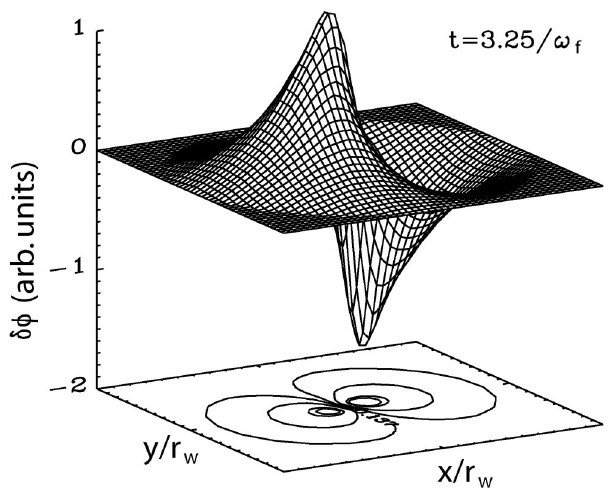
FIG. 5. The x - y projection (at fixed value of z ) of the per- turbed electrostatic potential (cid:31)(cid:27) (cid:1) x; y; t (cid:2) for the ion-electron two-stream instability growing from a small initial perturba- t (cid:7) 3 : 25 tion, shown at ! f